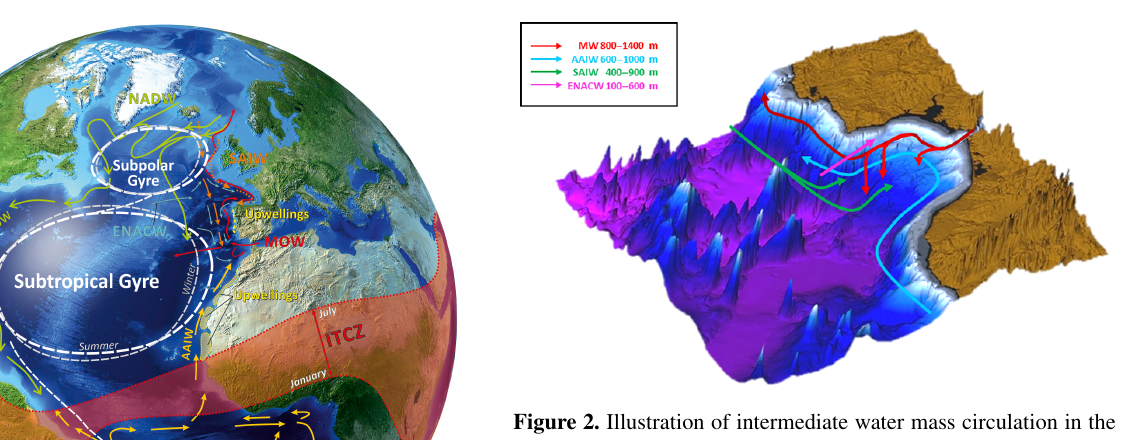
Figure 2. Illustration of intermediate water mass circulation in the GoC. The red line indicates the MW along the Spanish and Por- tuguese coast. The blue line is for the AAIW coming from the African coast from the south. The green line is for the modified SAIW coming from the northwest of the Iberian Peninsula. The purple line is for the ENACW coming from the western part of the